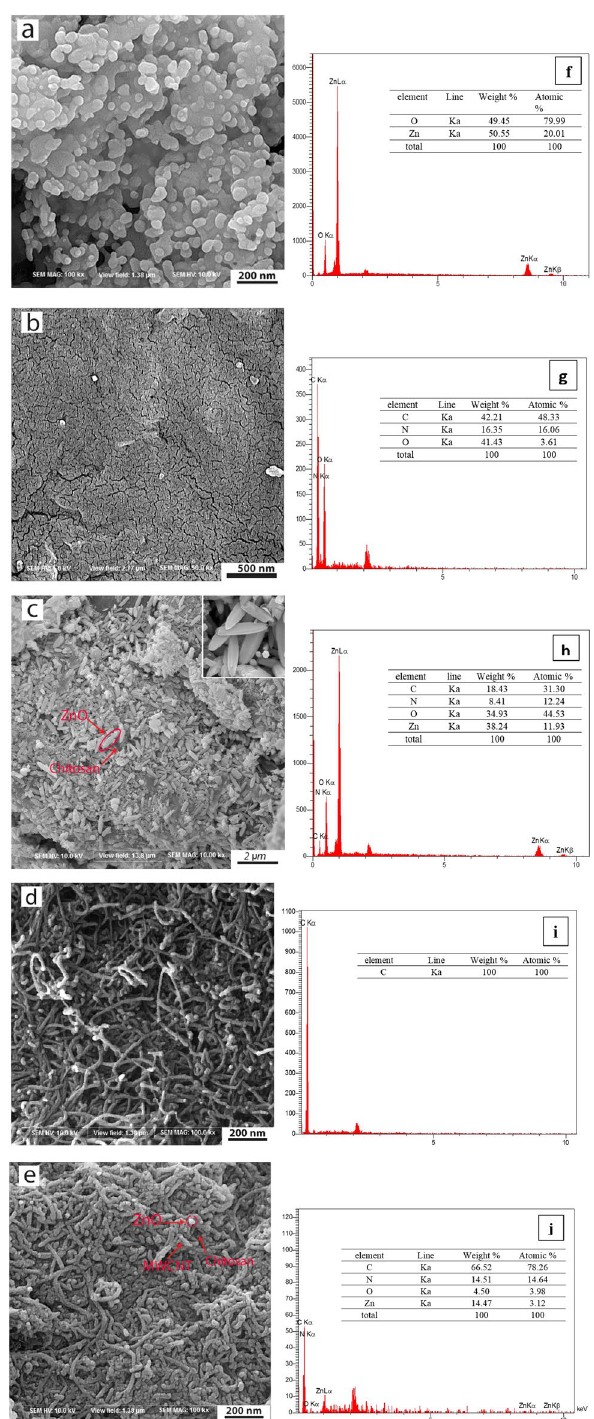
Figure 2. FESEM images of ( a ) pure ZnO, ( b ) pure Chitosan, ( c ) ZnO/Chitosan nanocomposite, ( d ) pure MWCNTs and ( e ) MWCNTs/ZnO/Chitosan nanocomposite; EDS spectra of ( f ) pure ZnO, ( g ) pure Chitosan, ( h ) ZnO/Chitosan nanocomposite, ( i ) pure MWCNTs and ( j ) MWCNTs/ZnO/Chitosan